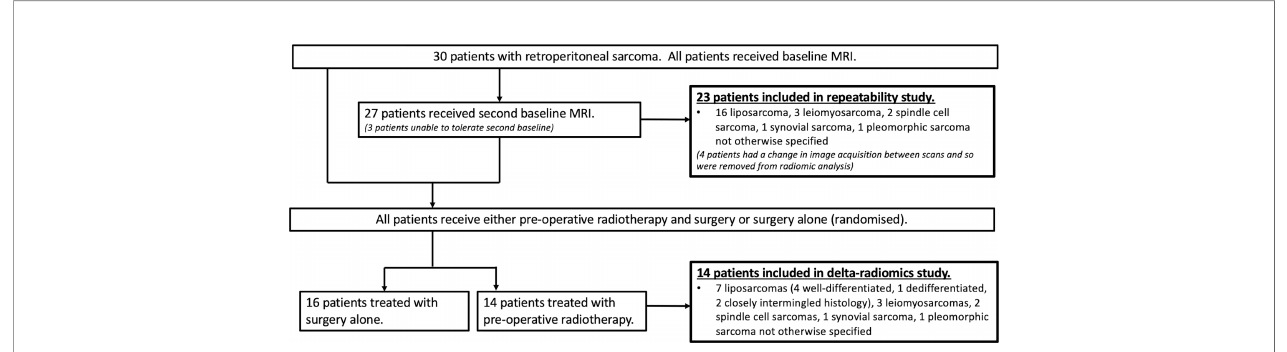
FIGURE 1 | Flowchart of the study population. Flowchart showing the numbers of patients and histology included in each of the repeatability and delta-radiomics analysis sections of the study. Figure adapted from